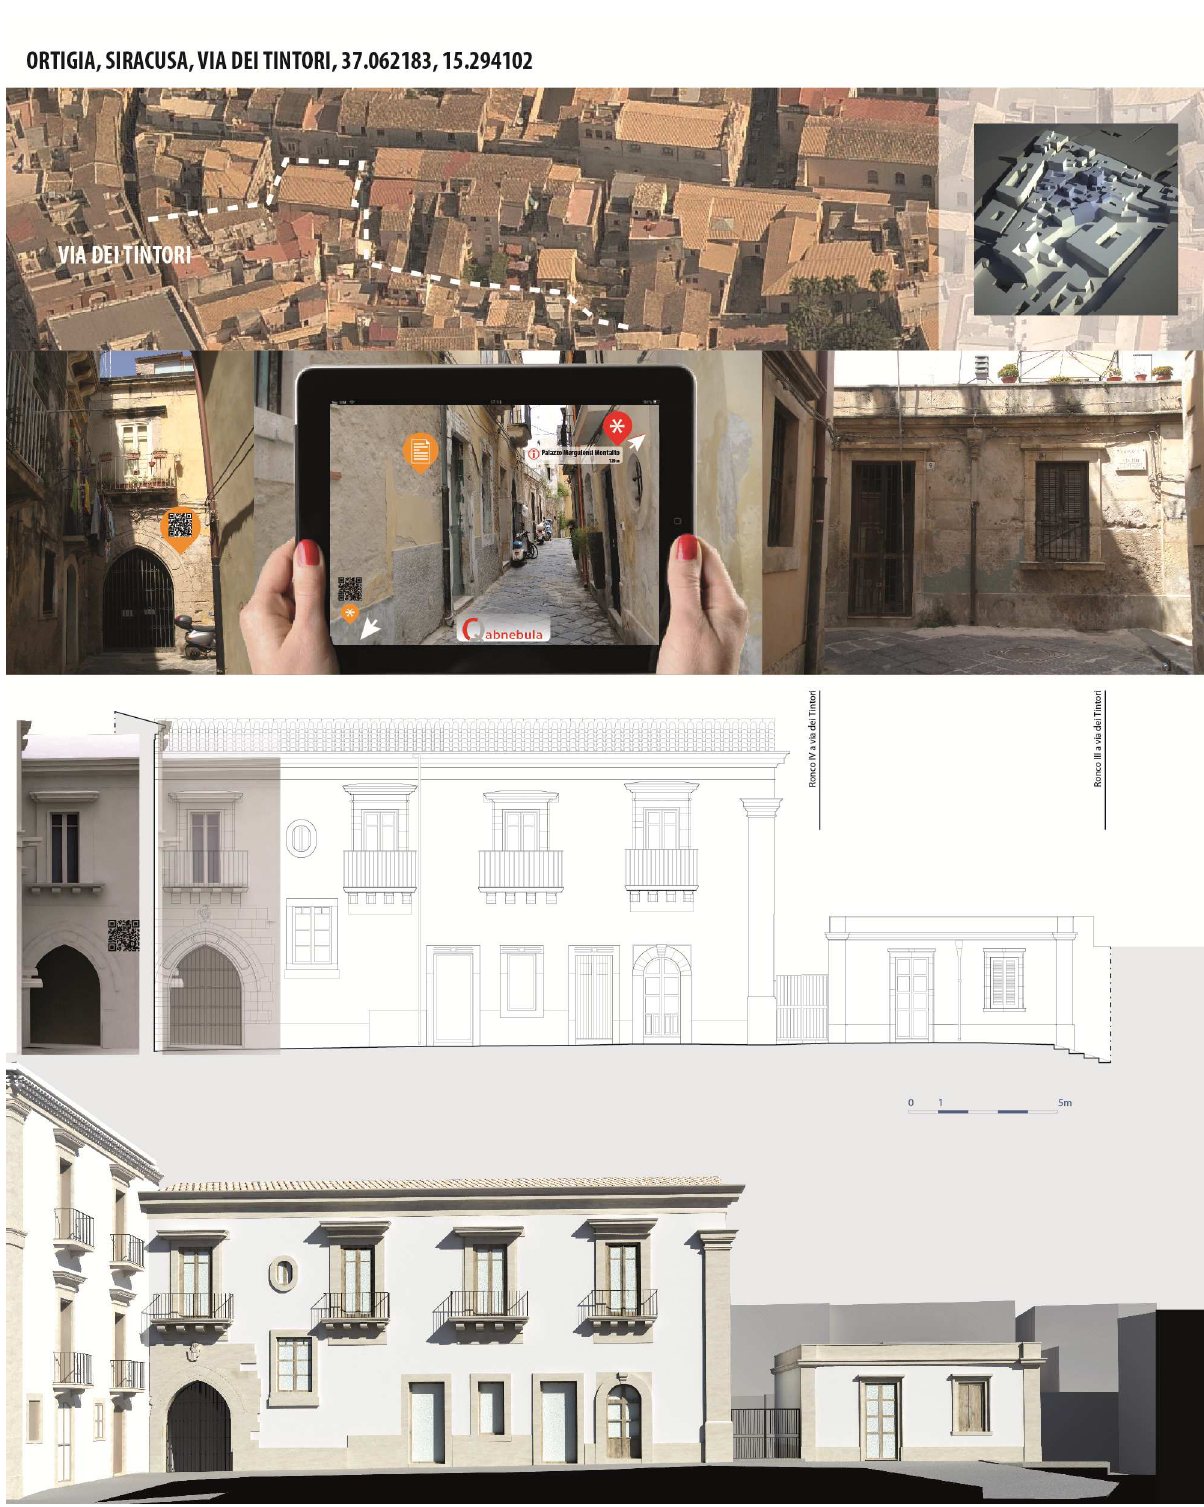
Figure 1. Examples of interaction between add ins of the “ Charter of Quality ” document in the process of the knowledge of